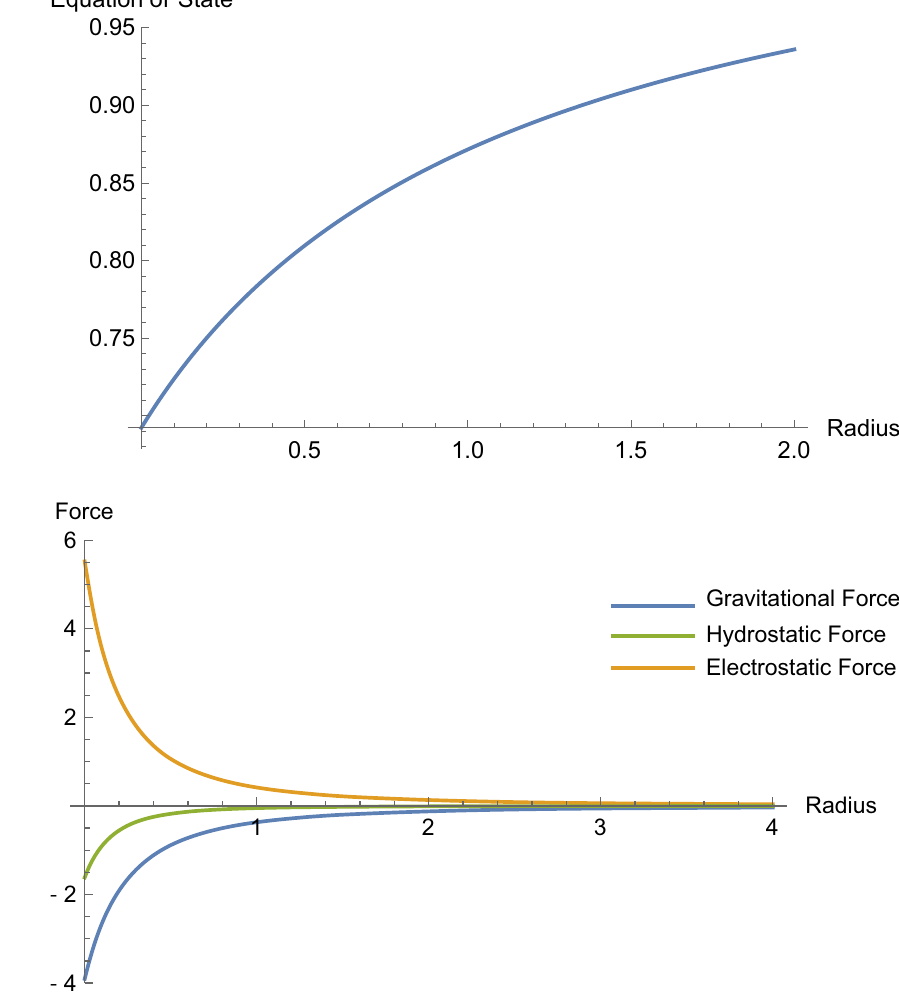
Fig. 19 Equation of state p ρ versus the radial variable x